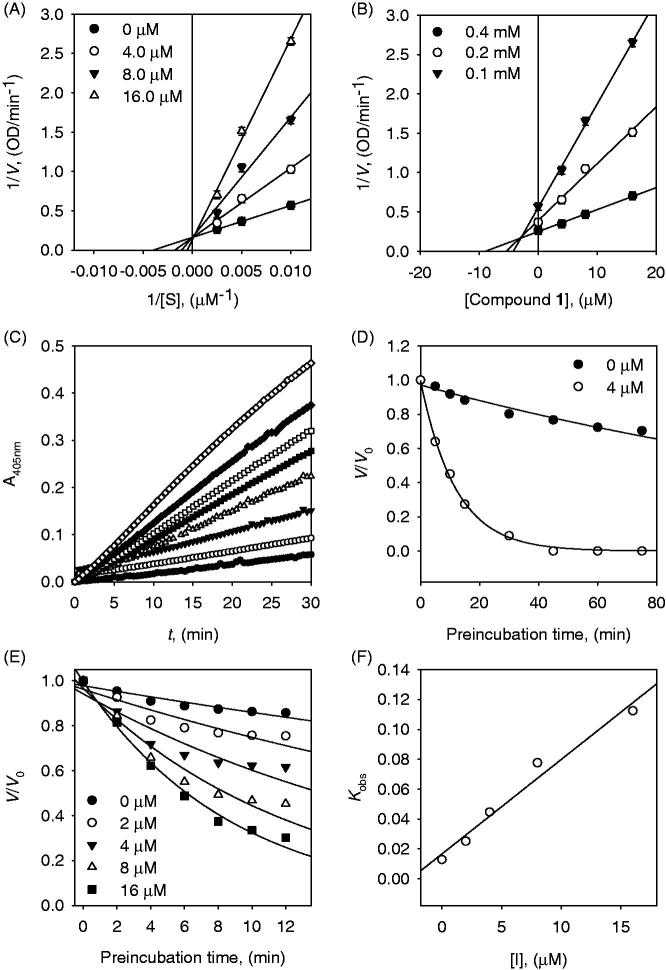
(A) Lineweaver–Burk and (B) Dixon plots for the inhibition of compound 1
on the α-glucosidase activity. (C) Slow-binding inhibition at different preincubation
time (◇: 0; ◆: 5; □: 10; ■: 15; △: 30; ▼: 45; ○: 60; ●: 75 min) for compound
1 at 4 μM. (D) Inhibition as a function of preincubation time for
compound 1. (E) Time course of the inactivation of α-glucosidase compound
1. (F) kobs on dependence on different
concentrations of compound 1.